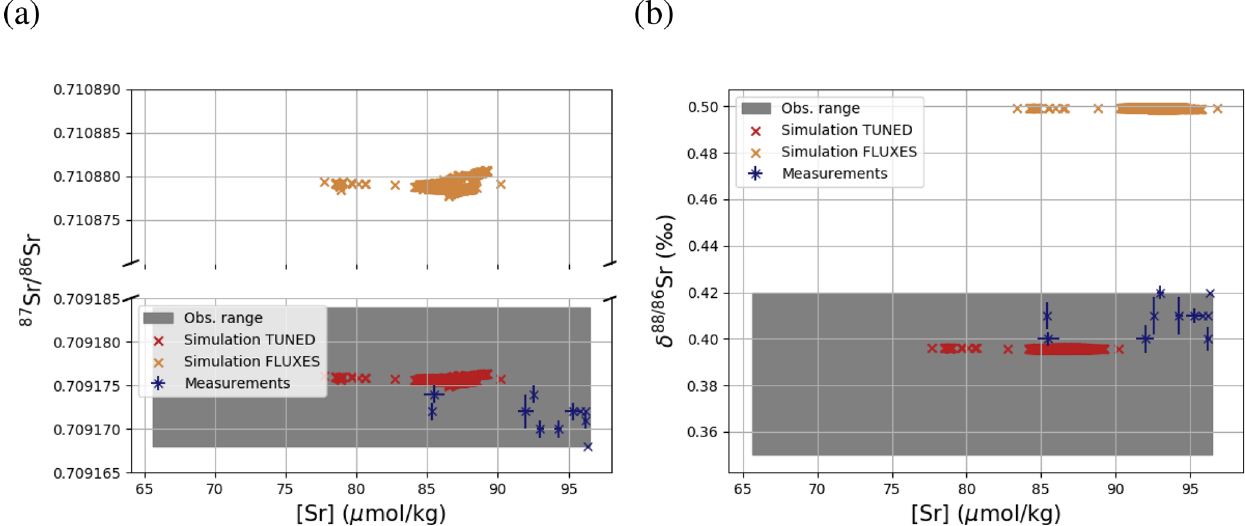
Figure 3. Comparison between measured and simulated concentrations (a) and isotopic composition (b) of dissolved Sr in seawater. The displayed data points are paired measurements of Sr concentrations and isotope ratios (Wakaki et al., 2017), while the gray box also indicates the full range of concentrations and isotopic compositions (separate measurements of Sr concentration or isotope ratios) (Angino et al., 1966; Fabricand et al., 1967; Bernat et al., 1972; Brass and Turekian, 1974; De Villiers, 1999; Mokadem et al., 2015). Observations and model results are salinity-normalized.